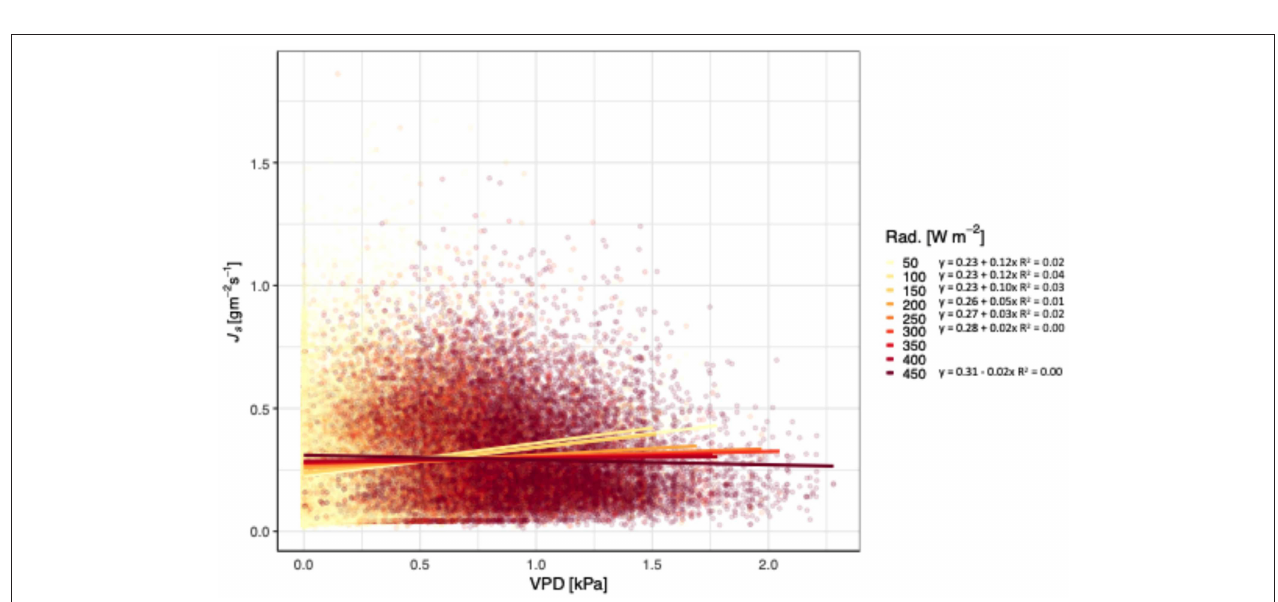
FIGURE 2 | Relationship between vapor pressure deficit (VPD; kPa), sap flux density ( J s ; gm − 2 s − 1 ), and air temperature (Temp. ◦ C) for Tectona grandis . Treatments (thinned and unthinned) are pooled. Colors represent binned hourly mean air temperatures (by 2 ◦ C) during daylight hours (07:00 to 18:00). Model equations for each temperature bin shown. R 2 values included for all models where p < 0.0001).